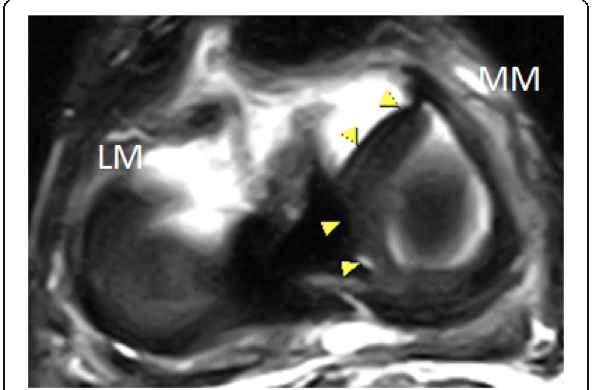
Fig. 7 Thin axial fat-saturated PD WI revealed a displaced medial meniscal bucket handle tear. Note the centrally displaced torn inner